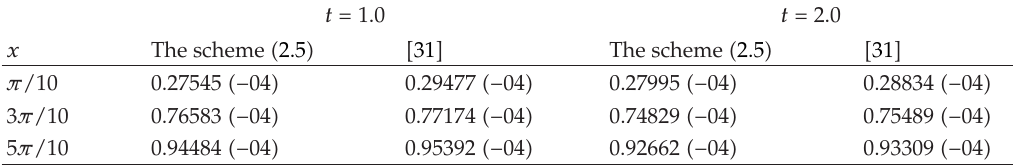
Table 3: Absolute errors of scheme (cid:3) 2.5 (cid:4) and scheme (cid:3) 16 (cid:4) in (cid:6) 31 (cid:7) (cid:3) h (cid:9) π/ 30 , τ (cid:9) 0 . 001 (cid:4) . t (cid:9) 1 . 0